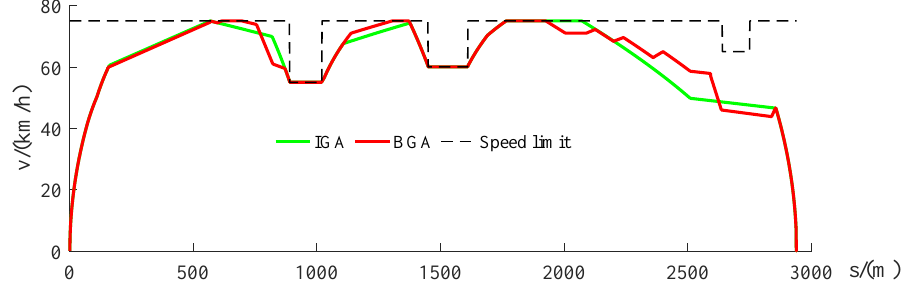
Figure 15. The target speed curves obtained by basic genetic algorithm (BGA) and IGA. Table 3. The results of the optimization